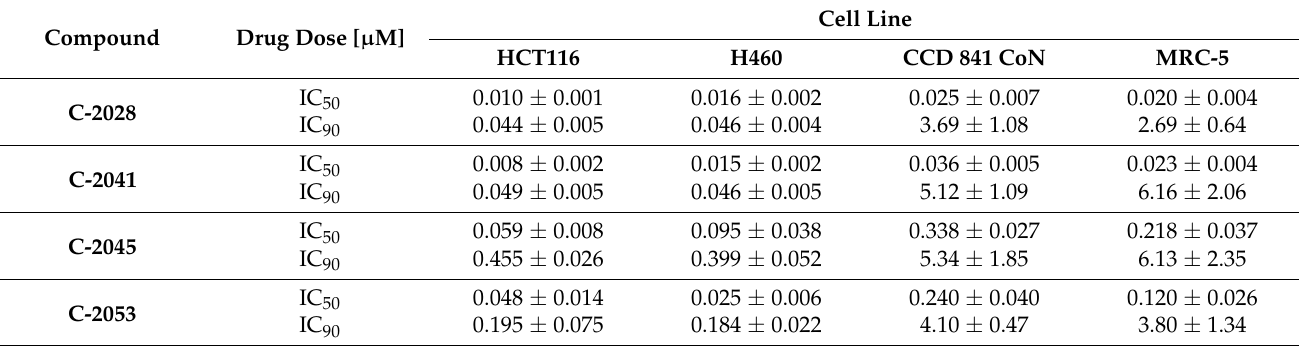
Table 1. Cytotoxicity of UAs against HCT116, H460, CCD 841 CoN and MRC-5 cells ( n ≥